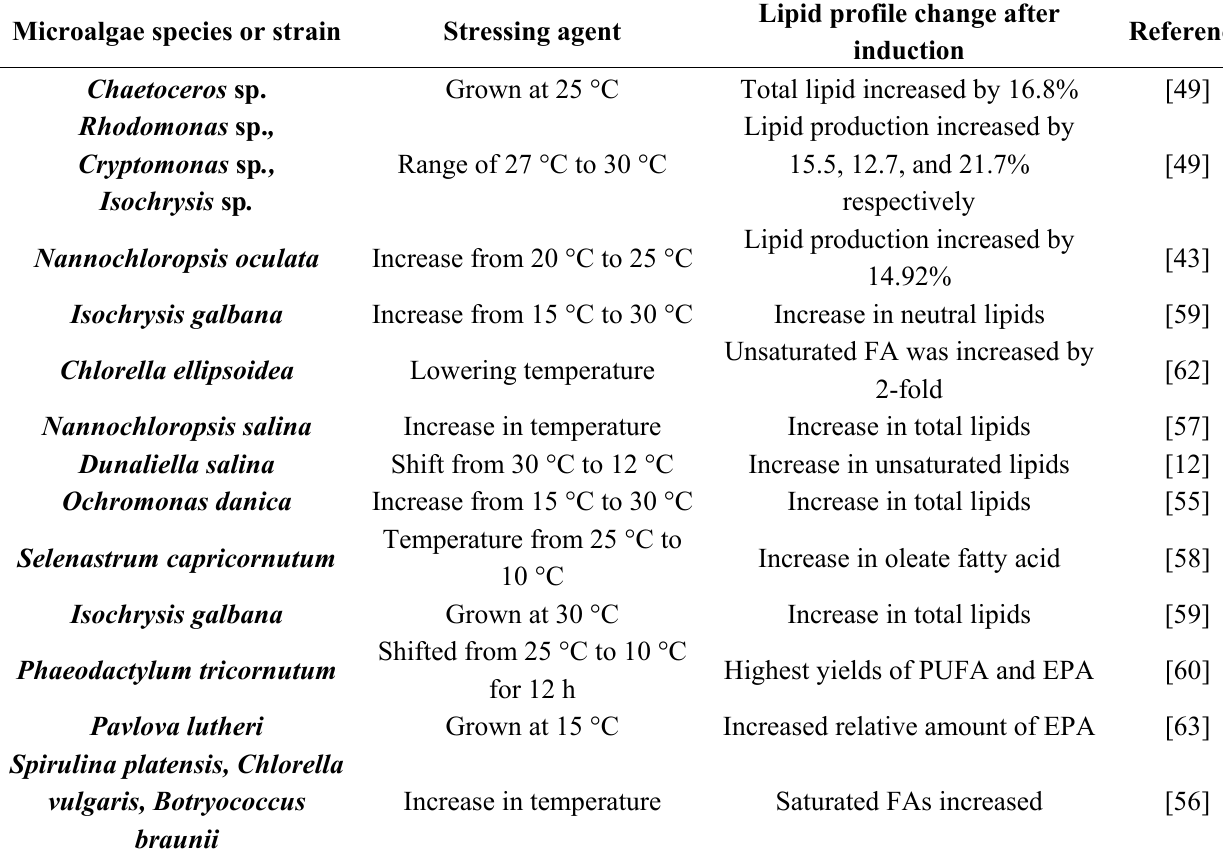
Table 2. Lipid induction in microalgae with different